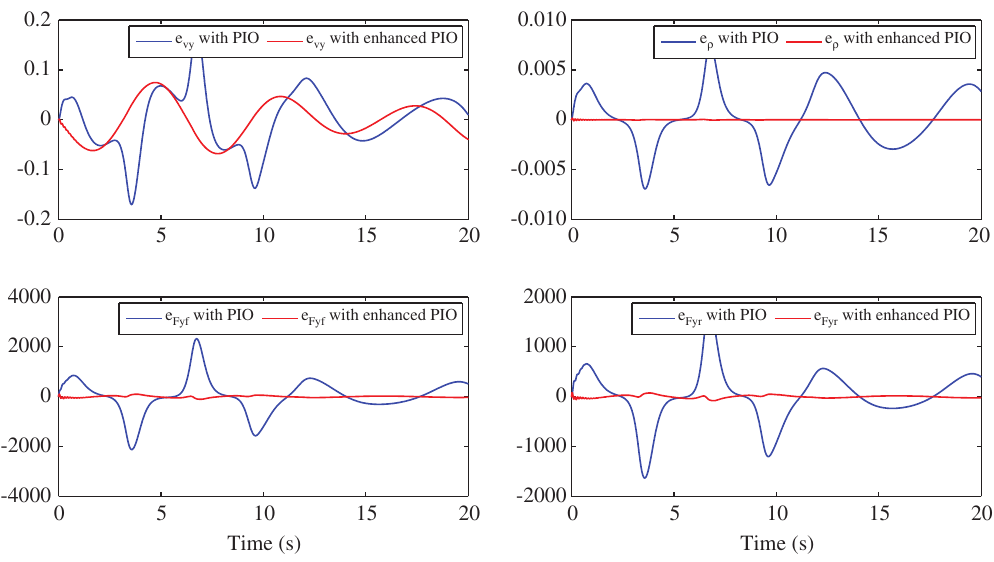
Figure 2. Comparison between Conventional PI Observer and Enhanced PI Observer